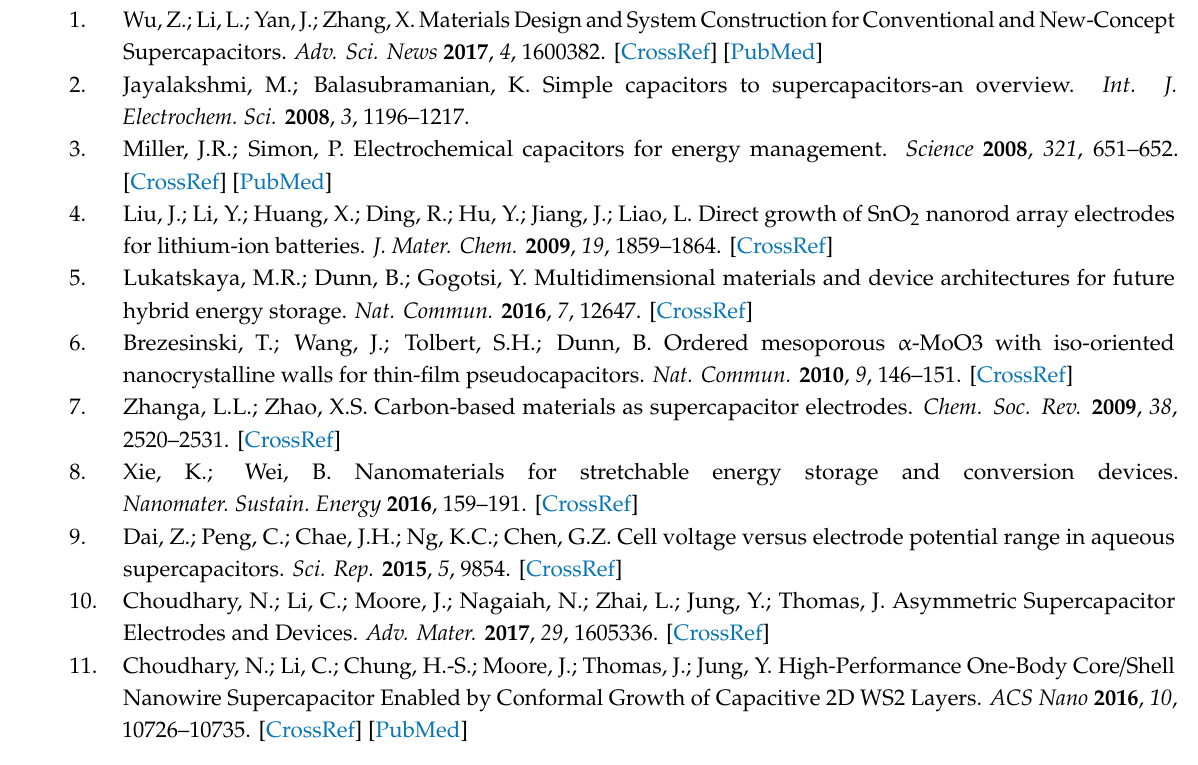
Figure S1: (a,b) cyclic voltammetries recorded at di ff erent scan rates for both MnO x and Mn 3 O 4 (before and after thermal treatment, respectivelly), (c,d) cyclic voltammetries and capacitance comparison for MnO x and Mn 3 O 4 , Table S1: comparison of voltage windows and specific capacitances. Author Contributions: Conceptualization of the supercapacitor design, electrodes assembly, and electrochemical characterization, interpretation of results, writing and editing M.S.; TEM, FESEM and XPS analyses, interpretation, writing and editing M.F.; XRD and Raman measurements with interpretation and editing S.B.; participation in most of the experimental data interpretation, supervision and participation in manuscript writing and editing C.F.P. and A.L.; synthesis of Mn 3 O 4 U.Z.; synthesis of MoS 2 P.R.; participation in the synthesis, electrode fabrication, device fabrication, electrochemical characterization and writing main draft A.R. All authors have read and